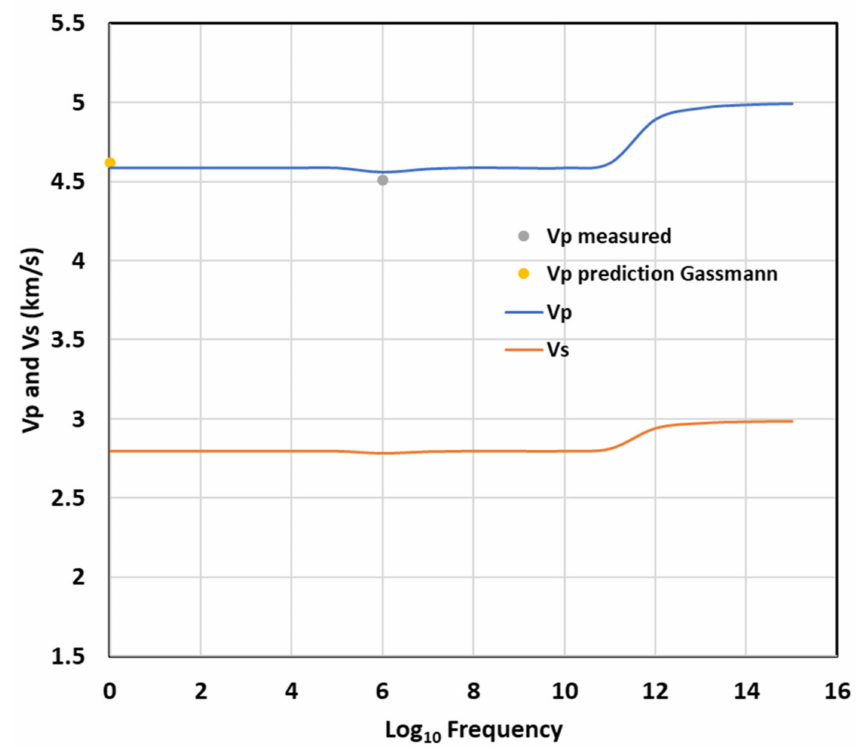
Figure 10. Cotton Valley shale. Cross plot of Squirt-flow P-wave (blue line) and S-wave (orange line) velocity predictions with log of frequency. Yellow data point is the Gassmann P-wave velocity prediction, while the gray data point is the measured P-wave velocity at ultrasonic